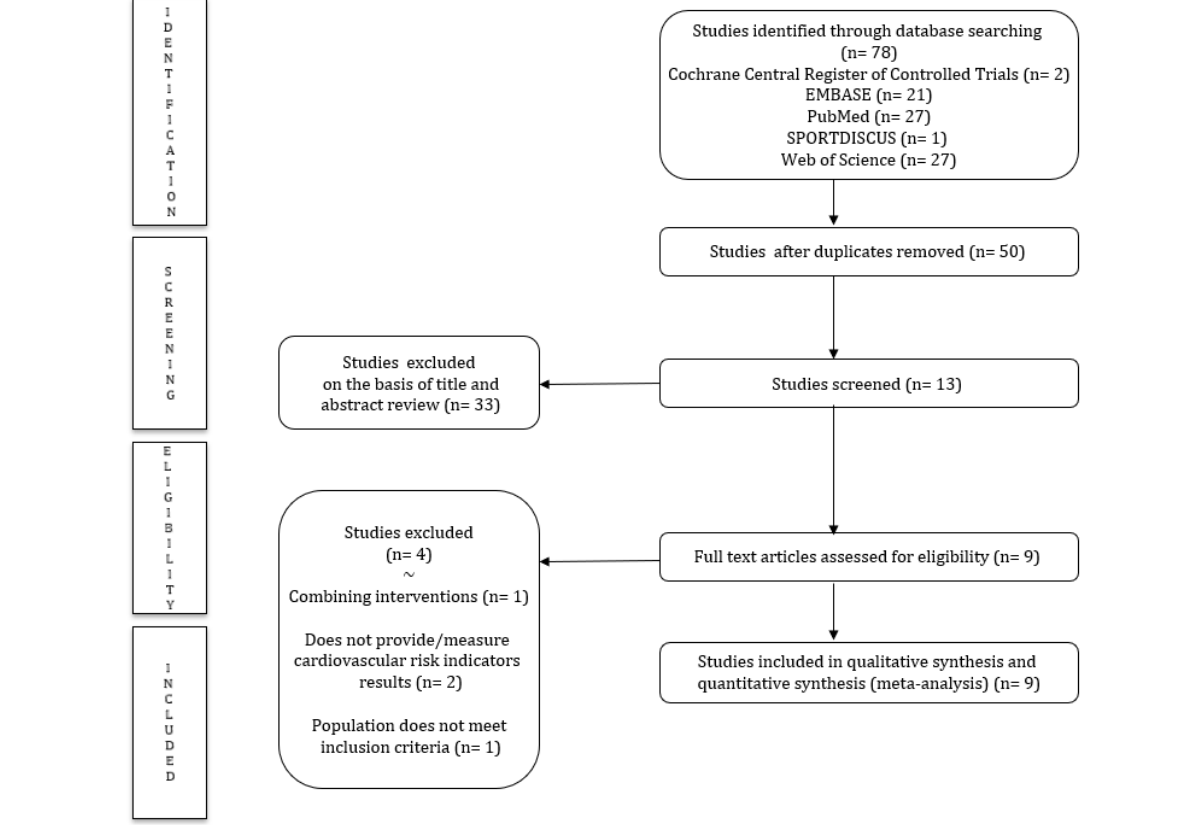
Figure 2. Preferred Reporting Items for Systematic Reviews and Meta-Analyses (PRISMA)